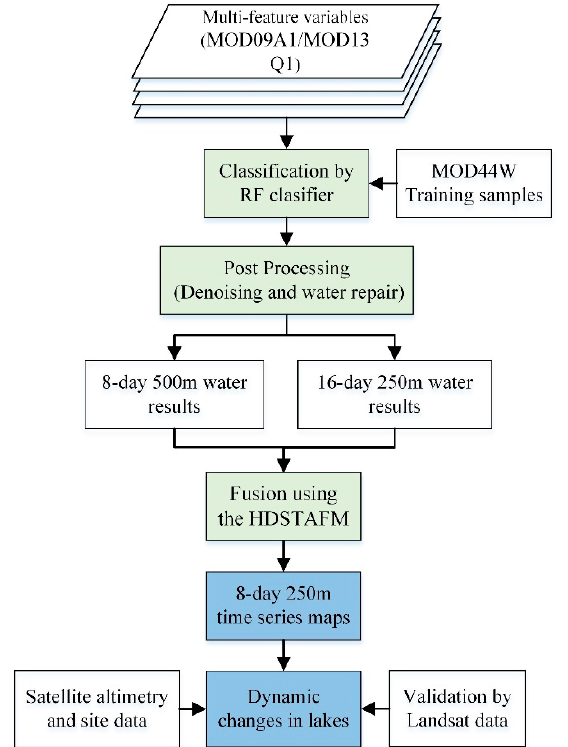
Figure 2. The flowchart of the research methodology.